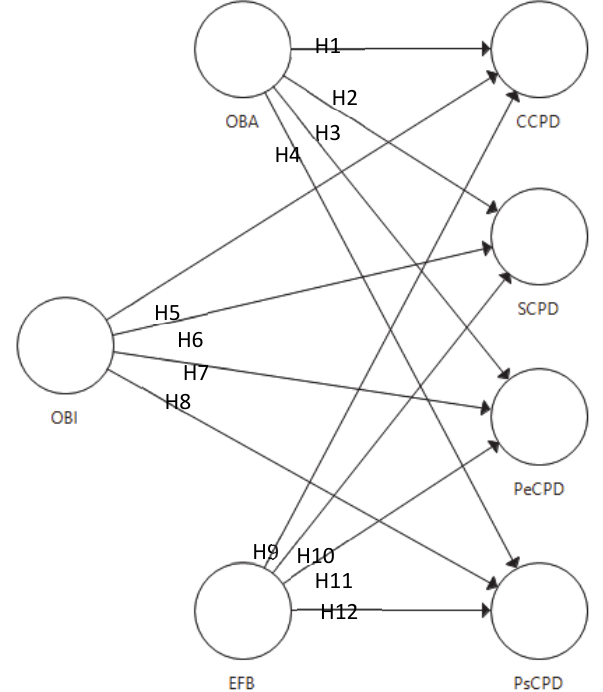
Fig. 1. Conceptual model and